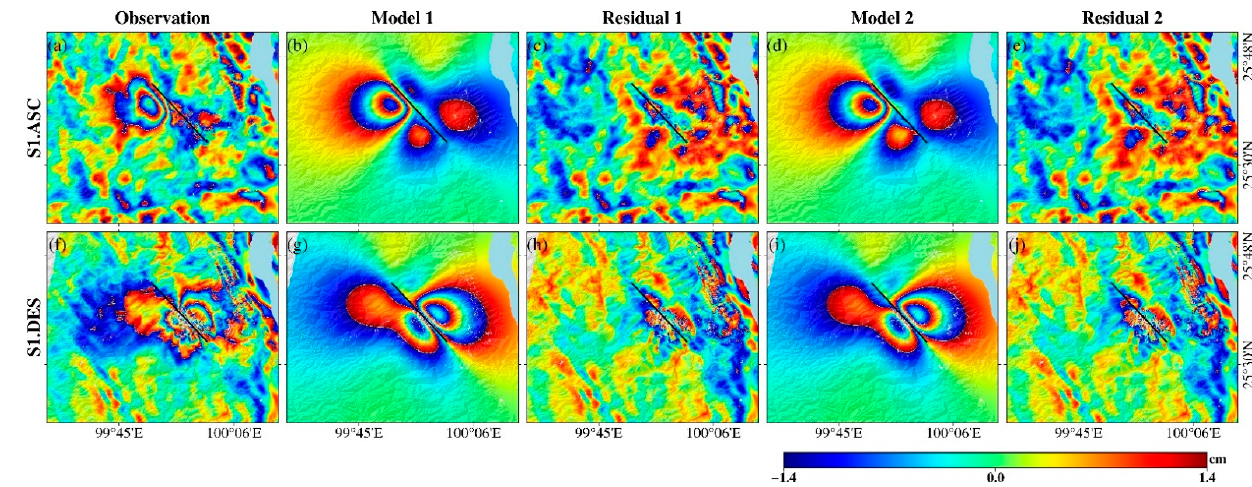
Figure 8. Observed and simulated LOS coseismic deformation fields and residuals obtained by Model 1 and 2 from the ascending data ( upper row ) and descending data ( lower row ). ( a , f ) The observation fields. ( b , g ) The modelled displacement fields form Model 1. ( d , i ) The modelled displacement fields form Model 2. ( c , h , e , j ) The residuals from Model 1 and 2, respectively.